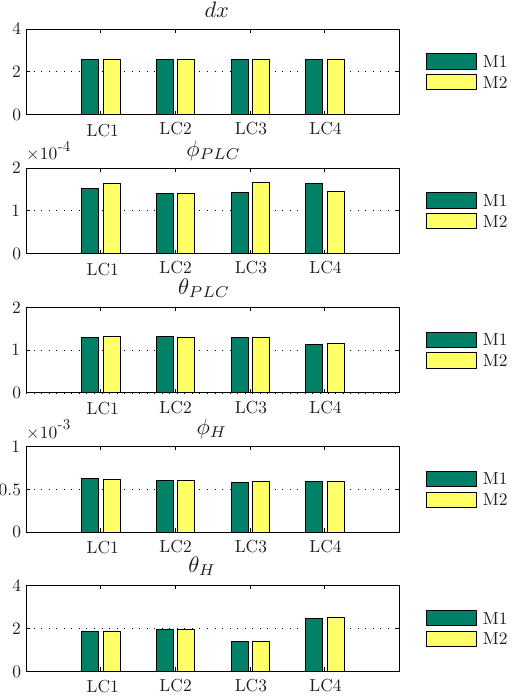
Figure 10: Comparison of parameters.